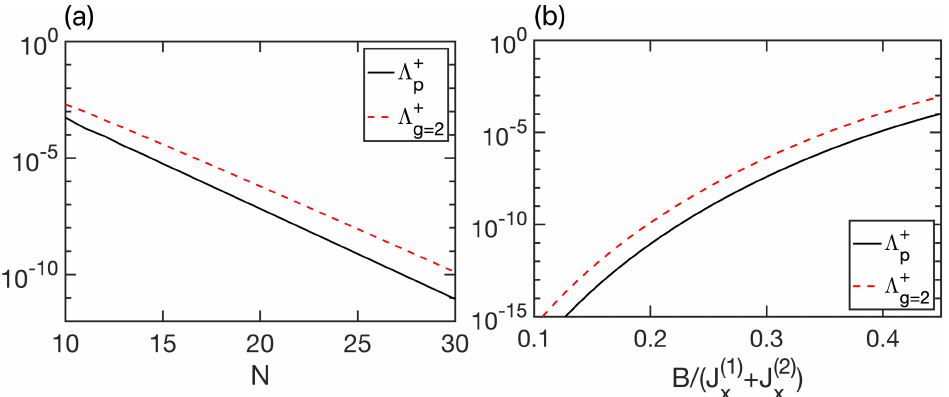
setting the dephasing dynamics (even parity Figure 8: Coefficients Λ + and Λ + p g = 2 = J ( 2 ) = 0 and J ( 1 ) = 0.25 J ( 2 ) subspace) in the open extended Ising model for J ( 1 ) at y y x x (a) with B = J ( 1 ) and at (b) with N = 30 spins, in the topological regime with g = x